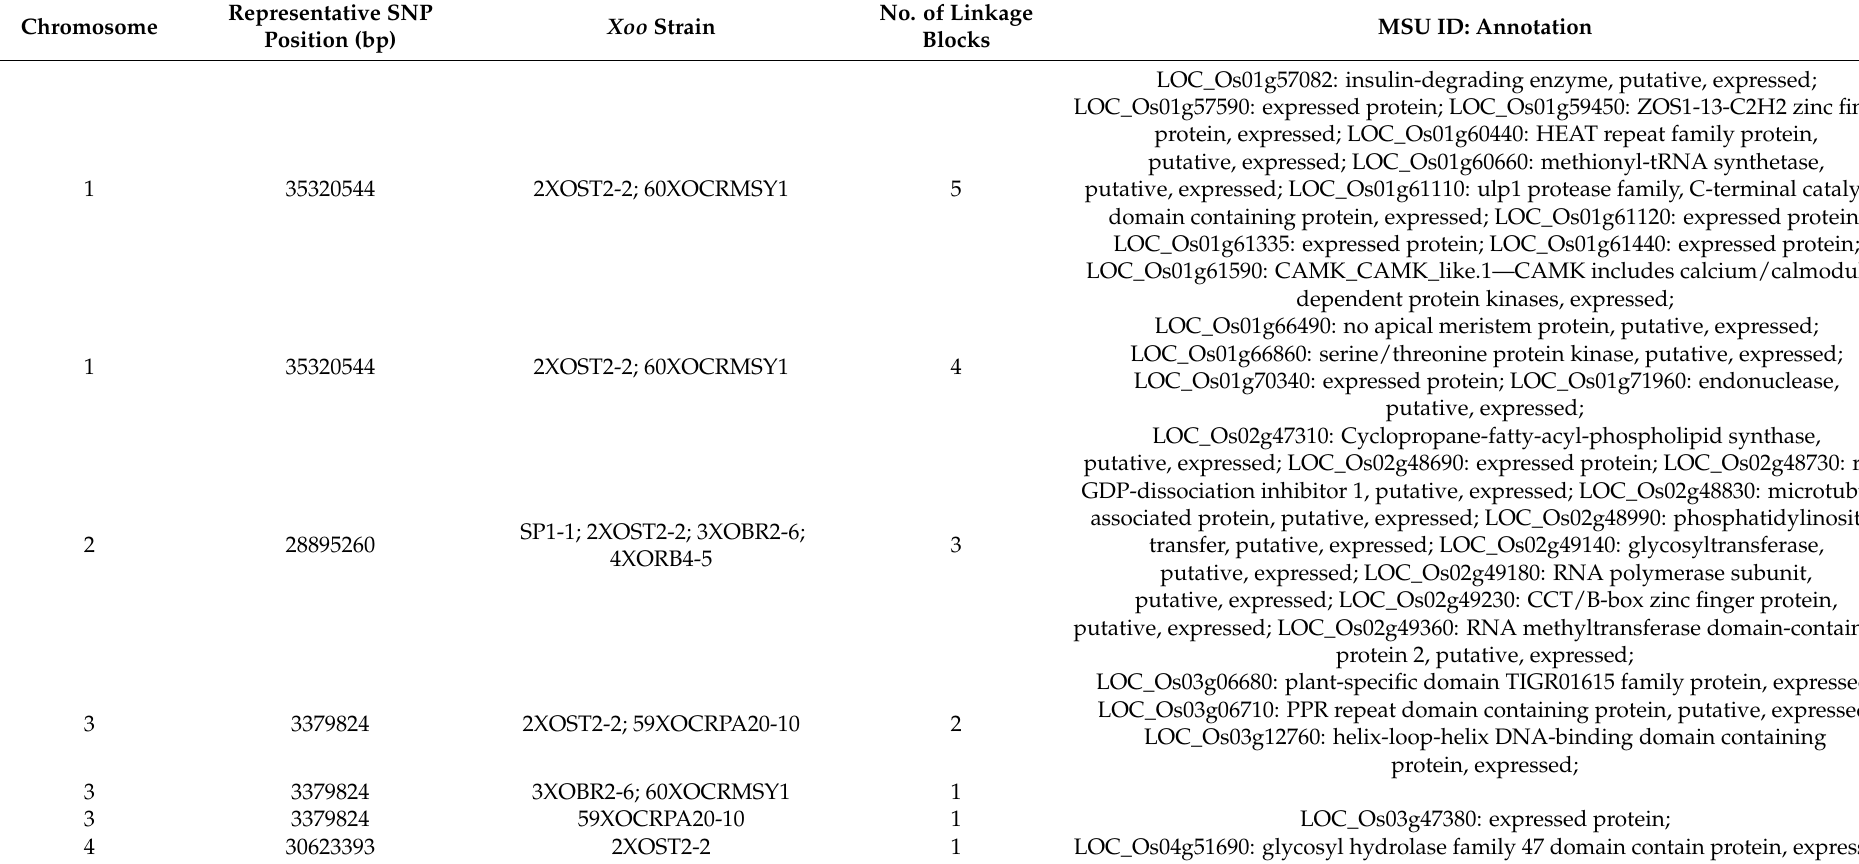
Table 2. Linkage clusters within 5Mb blocks across seven Xoo isolates. Clusters are delineated according to LD decay values for each chromosome.